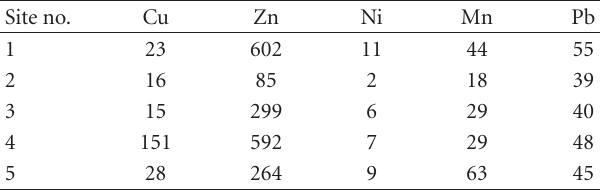
Table 7: Concentrations in river samples µ g/L – April. Site